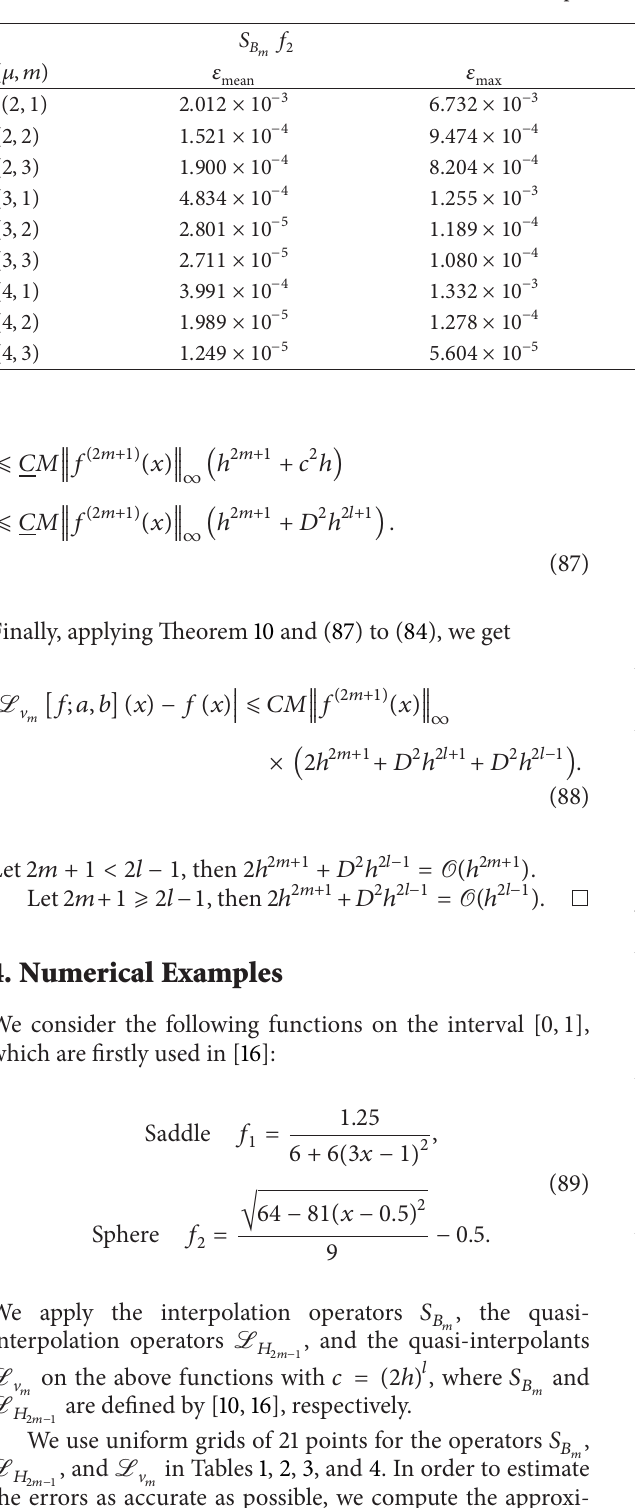
Table 3: Numerical results of the operators 𝑆 𝐵